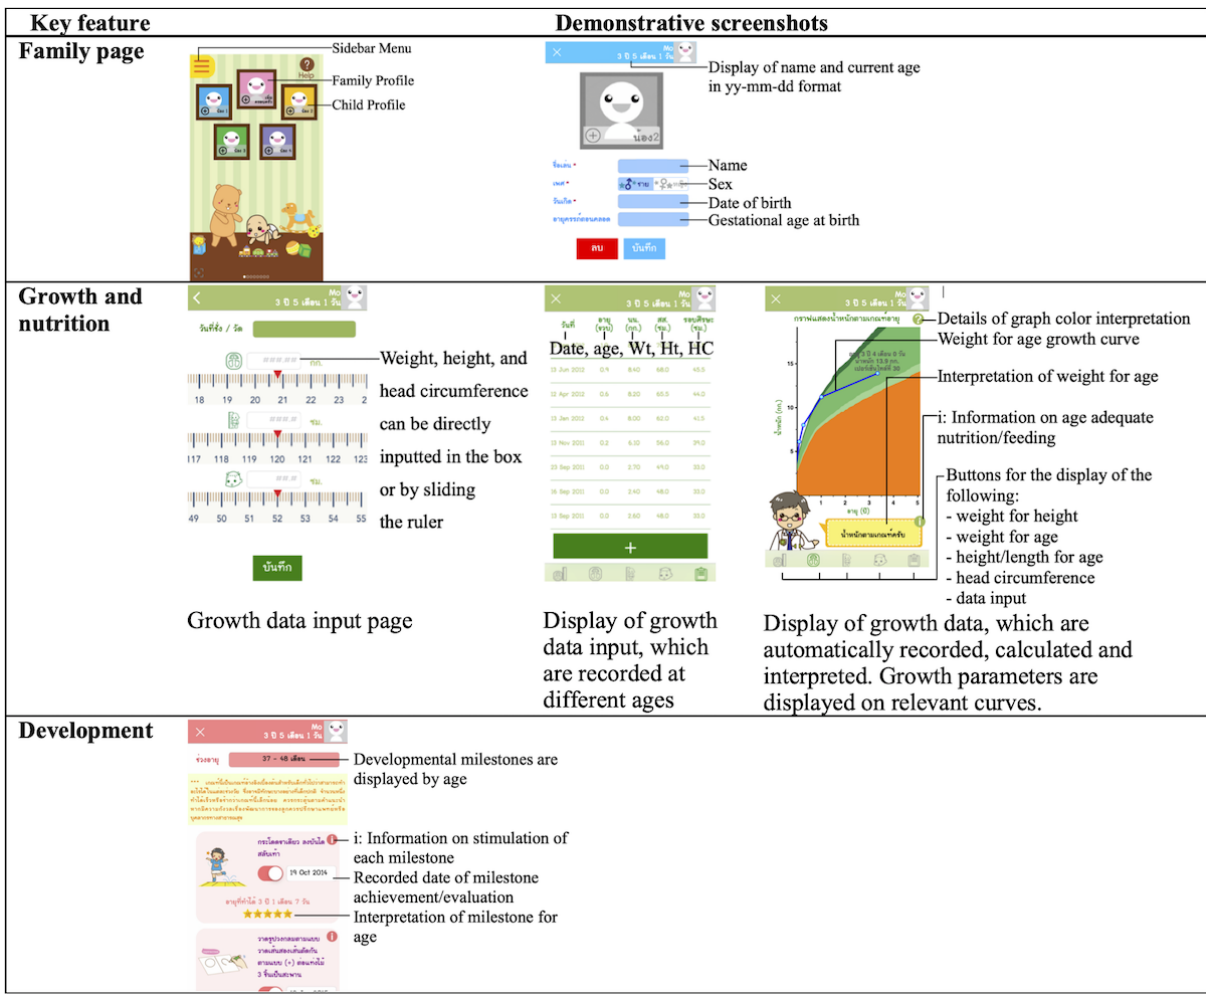
Figure 2. Demonstrative screenshots of the KhunLook